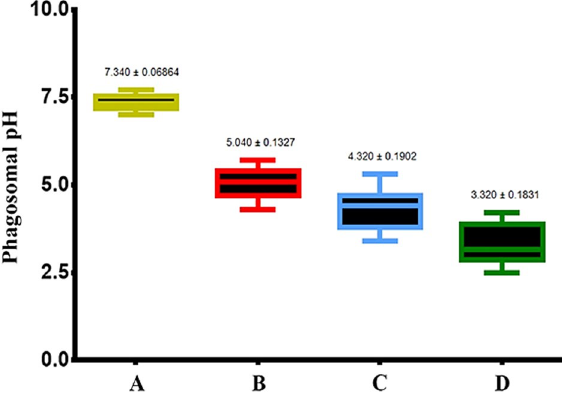
Figure 6. The prepared NPs increased phagosome maturation in BMDMs. Data are presented as the mean ± SD. ( A ) Control BMDMs. ( B ) BMDMs treated with functionalized SWCNTs. ( C ) BMDMs treated with SWCNTs decorated with ZnO-Ag NPs. ( D ) BMDMs treated with SWCNTs decorated with